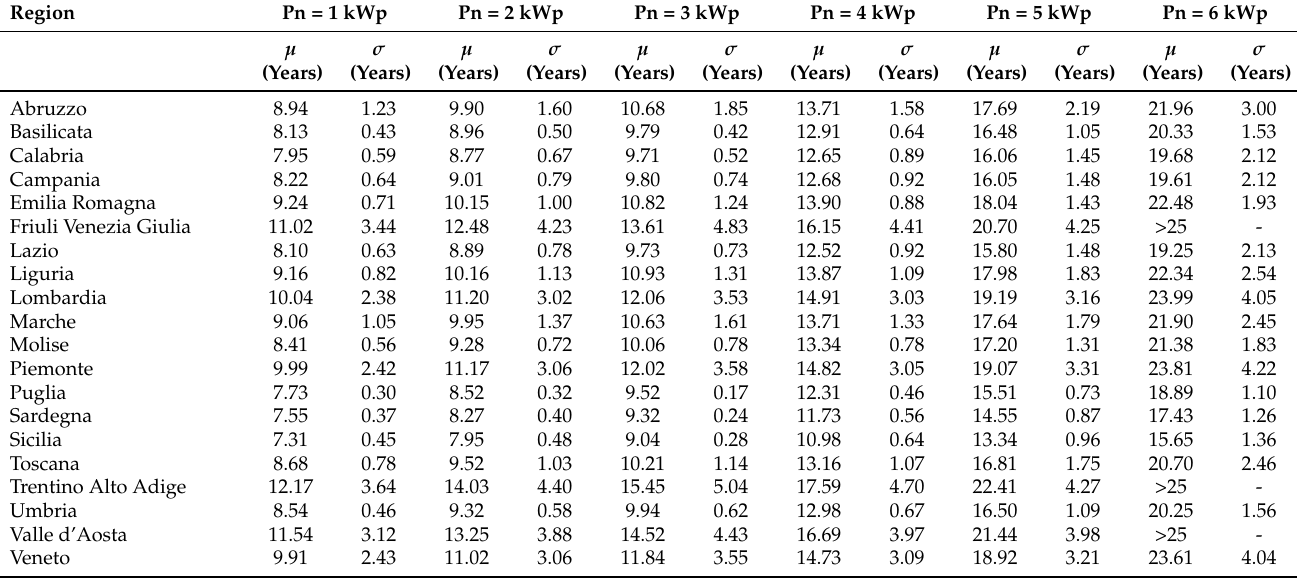
Table 19. DPBT for E L = 4000 kWh without battery.